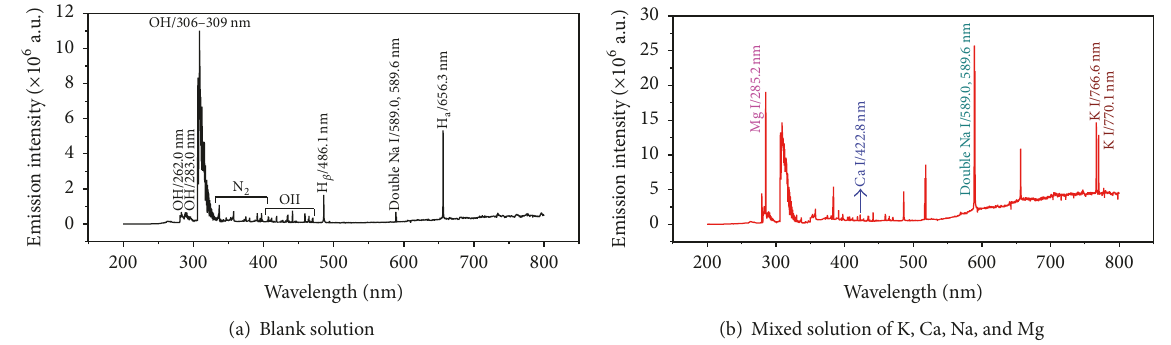
Figure 2: Typical LCGD-AES spectrum of the pH = 1.0 HNO 3 blank solution (a) and 50 mgL −1 K, Ca, Na, and Mg mixture solution adjusted to pH = 1 with HNO 3 (b) (discharge voltage: 650 V, flow rate: 3 mLmin −1 , interelectrode gap: 2 mm, and capillary diameter: